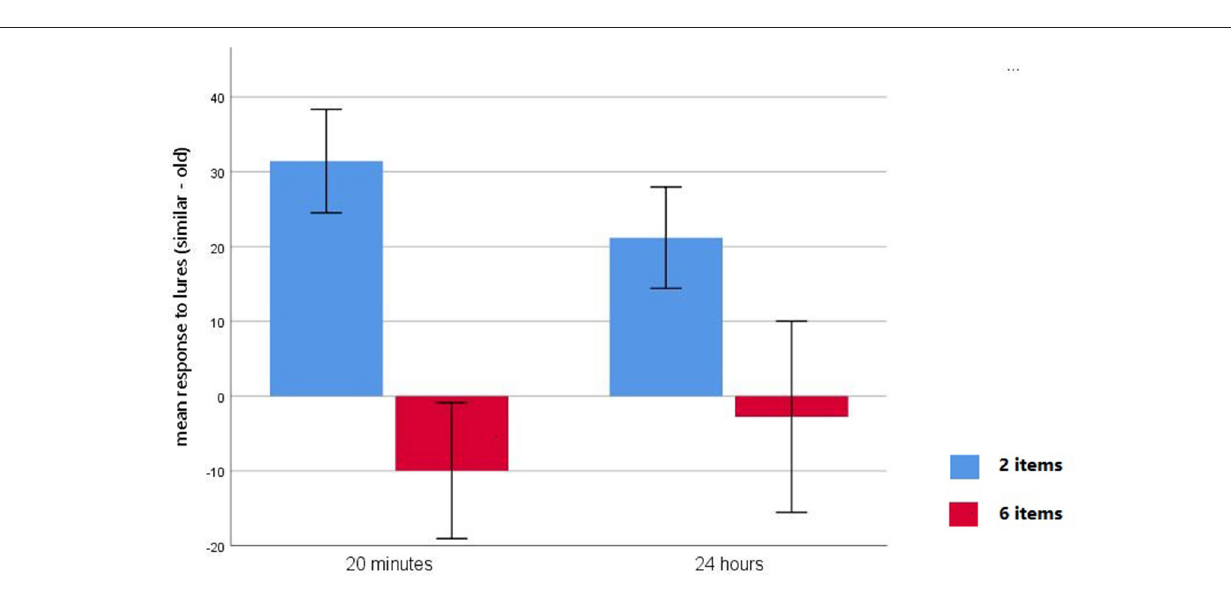
FIGURE 3 | Mean difference scores (number of similar correct rejections minus number of similar false alarms) for 2-item condition (blue bars) and 6-item condition (red bars) with a 20-min delay and a 24-h